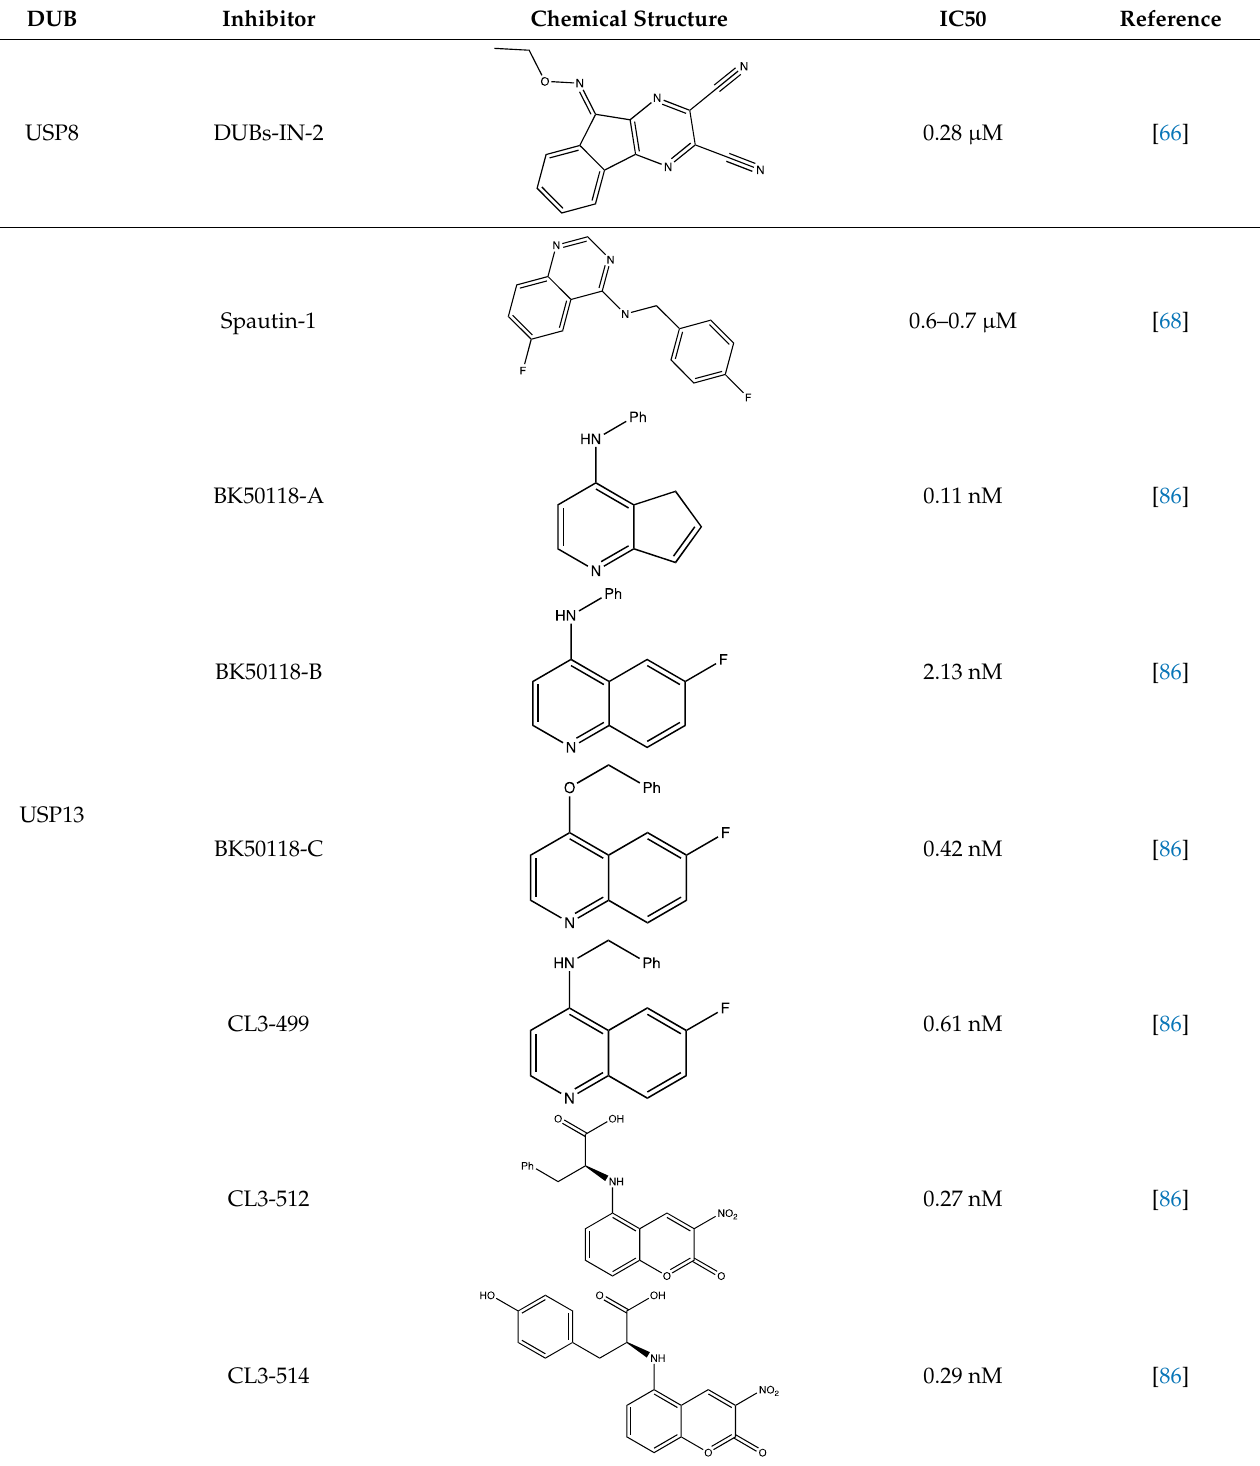
Table 2. IC50 of the inhibitors currently described in the literature for USP8, USP13 and USP30.